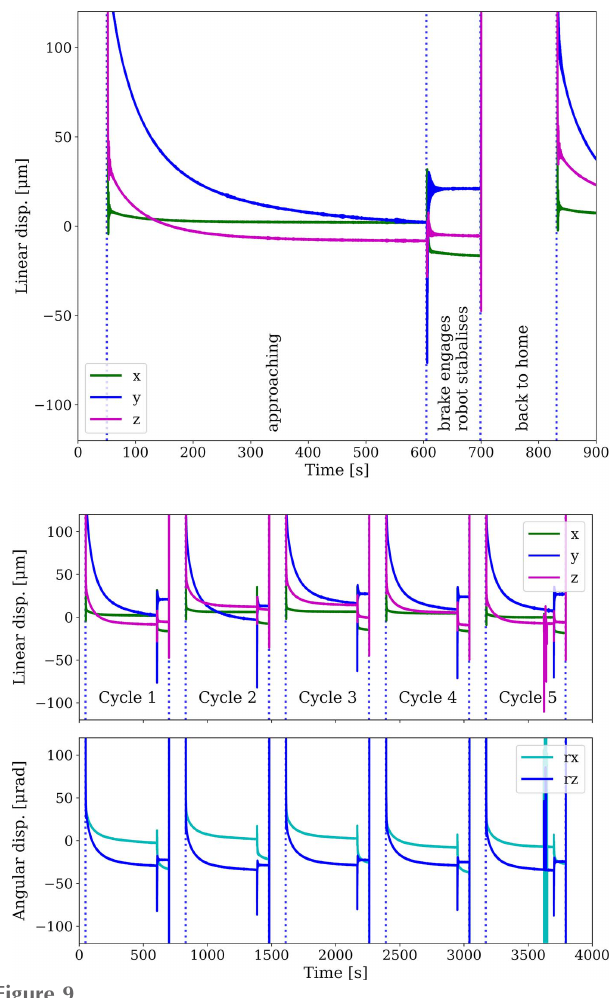
Figure 9 Capacitive sensor readings showing linear displacement during a single positioning cycle (top), and linear and angular displacement plot of multiple approaches (bottom).